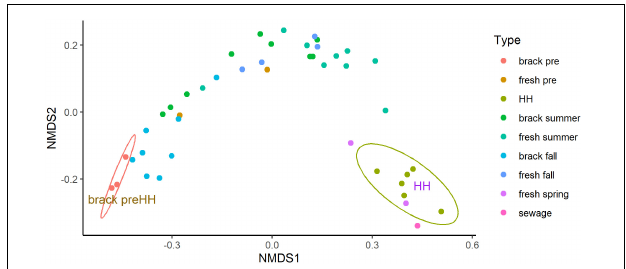
FIGURE 6 | Non-metric multidimensional scaling analysis (NMDS) of microbial community structure for samples collected before and after Hurricane Harvey. NMDS was run on the abundance of amplicon sequence variants as described in Methods. Type indicates segment (see Figures 1 , 2 ) sampled and season: “brack” corresponds to segments 2245 and 2245B, “fresh” corresponds to segments 1101, 1101C, and 1113B, “sewage” indicates a sewage-spiked sample and “HH” indicates samples collected immediately after HH. Eclipses were drawn to highlight indicated two coherent clusters supported by 95% confidence intervals. Figure was generated with scripts in Supplementary File 8